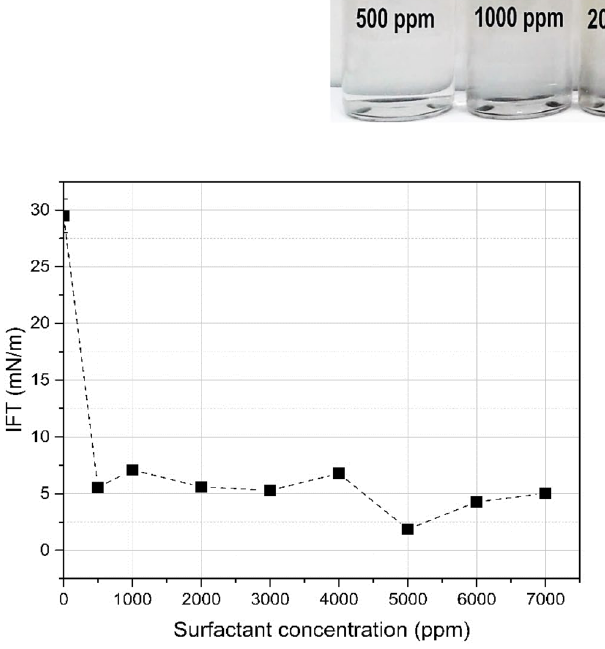
Fig. 11 IFT values measured between crude oil and Vitagnus sur- factant solutions at concentrations of 500–7000 ppm